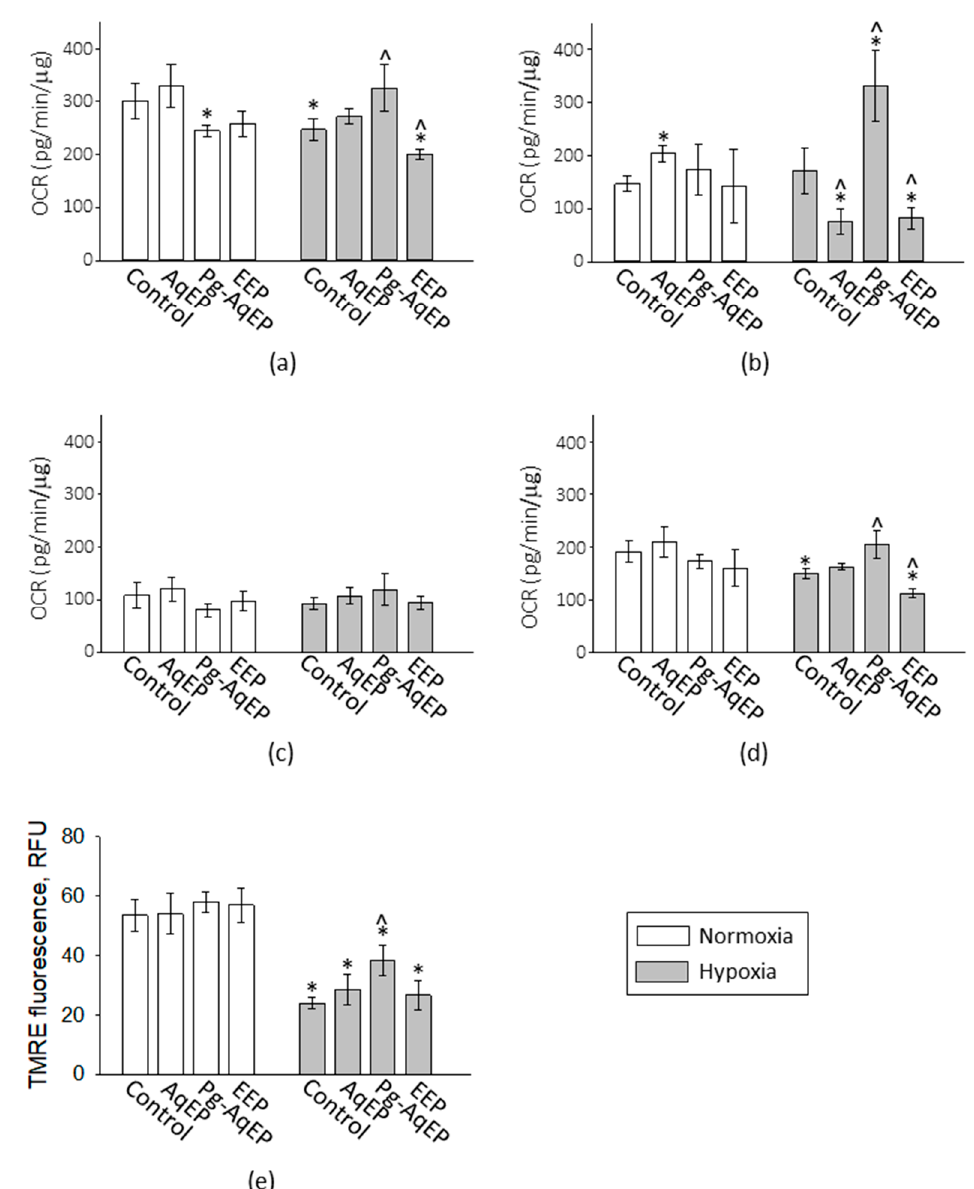
Figure 5. Mitochondrial function in hypoxia-treated cerebellar neuronal-glial cells with and without propolis extracts. The bioenergetics of the cerebellar cells were assessed by Seahorse Flux Analyzer using Cell Mito Stress Kit, and the summary data calculated from the curves presented in Supplementary Figure S1, are shown in this figure. Panel ( a ) shows the basal mitochondrial respiration rate expressed as the oxygen consumption rate (OCR); panel ( b ) is the maximal mitochondrial respiratory capacity, ( c ) is the OCR induced by the proton leak; and ( d ) the OCR that is coupled with phosphorylation and used for ATP production. ( e ) The mitochondrial membrane potential evaluated according to TMRE fluorescence. The data are normalized for total cellular protein and presented as the average ± SE of 3 experimental repeats performed in triplicate. *—statistically significant di ff erence compared to the normoxic control, p < 0.05; ˆ—statistically significant di ff erence compared to the hypoxic control, p < 0.05.